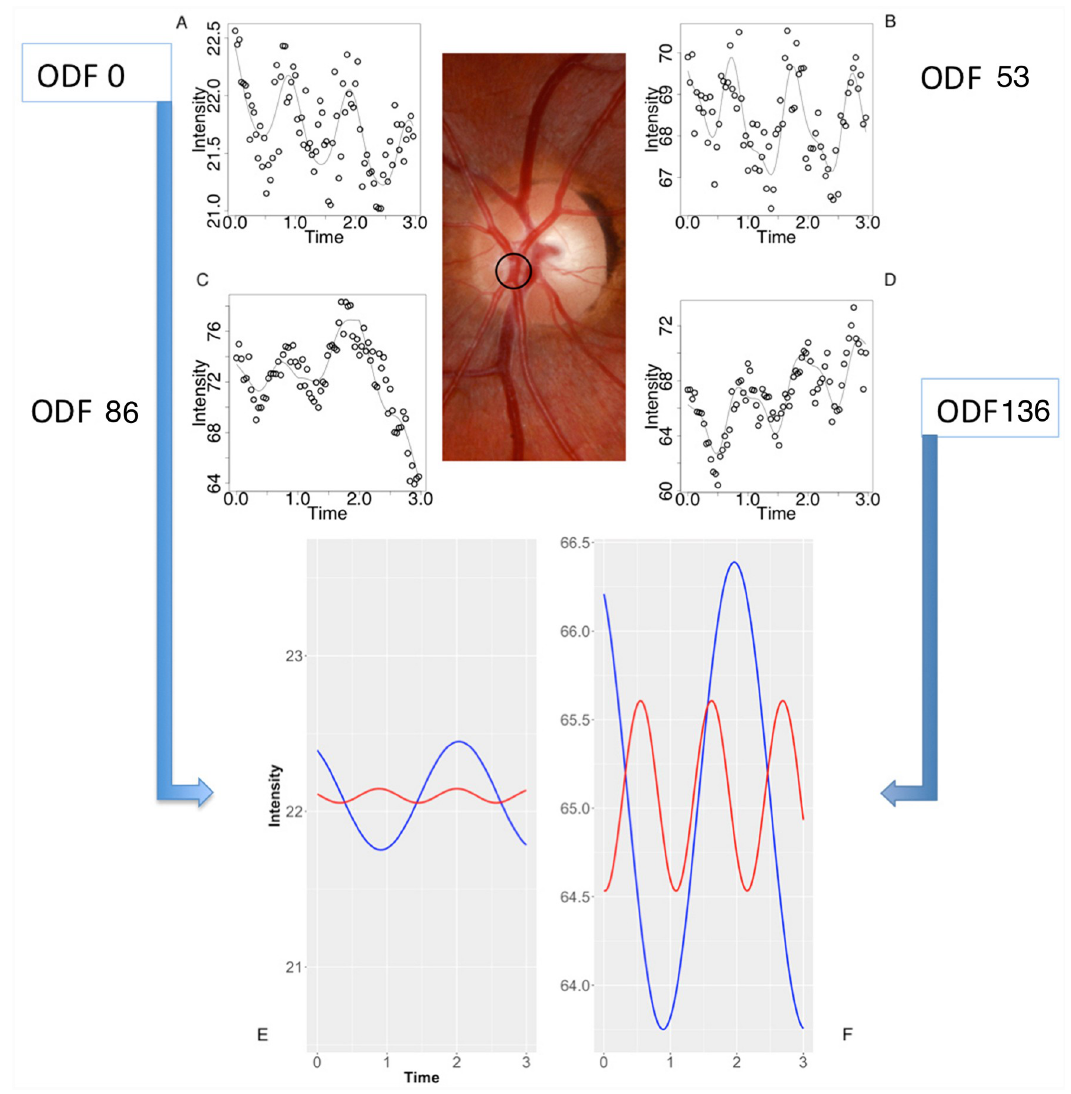
Fig 11. Composite image from the subject from Fig 9. (A-D) The retinal arterial pulse harmonic regression waveforms are represented graphically for ophthalmodynamometric force (ODF) 0, 53, 86 and 136 grams force. (E-F) The decomposed first (blue line) and second (red line) Fourier harmonic waves at ODF = 0 at (E) and ODF = 136 grams force at (F) calculated from the Fourier series equation for a single point as highlighted in the central color fundus image. Noted were the increase in the amplitude of the waveforms and the increase in the y-intercept of the regression line with increasing